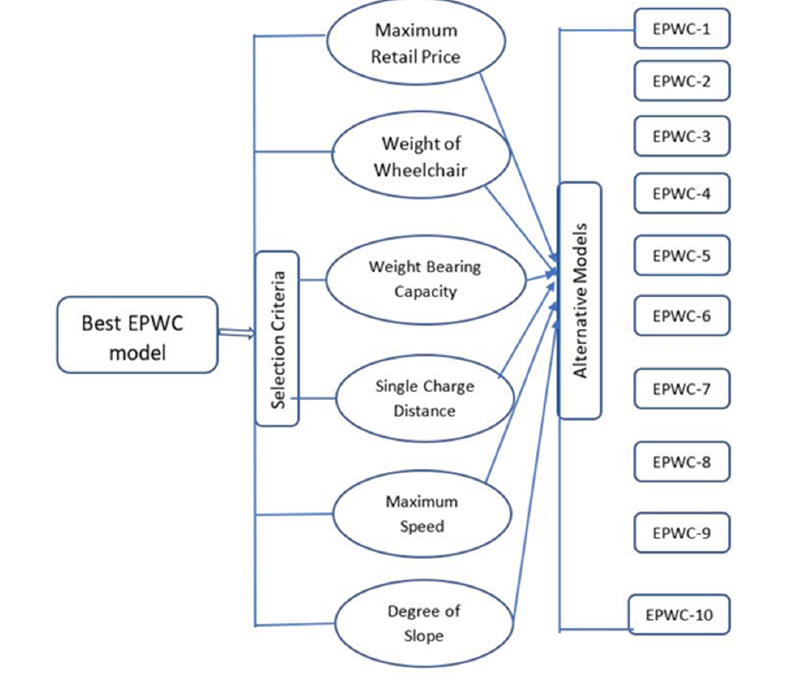
Fig. 1. A hierarchical tree of EPWC models with associated